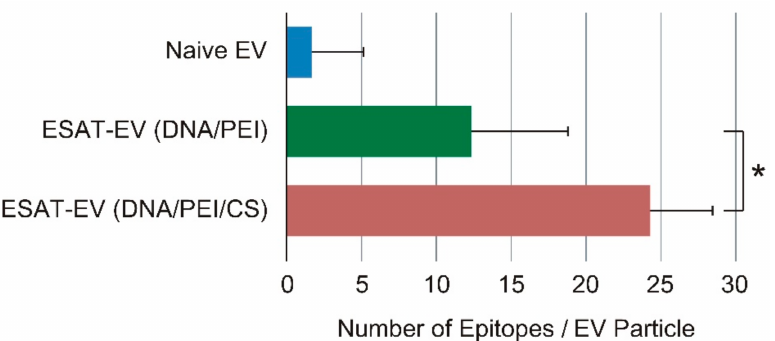
Figure 2. The number of ESAT-6 epitopes on EV particles secreted by the genetically modified tumor cells. EVs isolated from the culture medium of the transfected cells (ESAT-EV) by DNA/PEI binary complex, or DNA/PEI/CS ternary complex, and those from non-transfected cells (Naive EV) were trapped onto Tim-4-immobilized plate. The EVs were treated with rabbit anti-ESAT-6 antibody, and then FITC-labeled goat anti-rabbit IgG antibody. The amount of the antibody was estimated from the fluorescence intensity of the EVs using intact FITC-labeled goat anti-rabbit IgG antibody as standard ( n = 4, mean ± SD, * p <